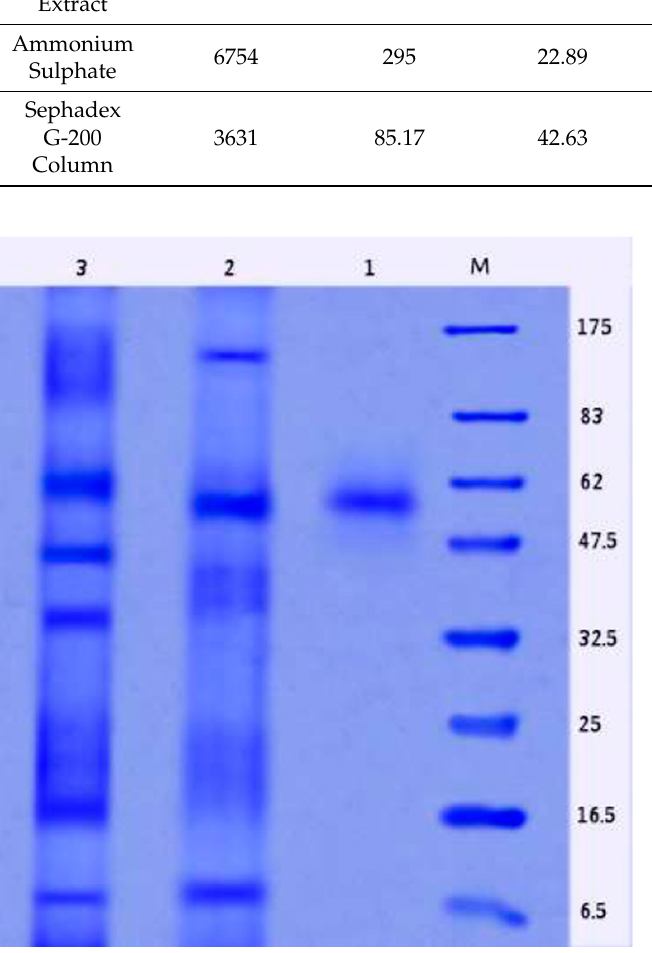
Figure 8. SDS-polyacrylamide gel electrophoresis of the purified enzyme. M: protein marker; 1: Sepharose 6B purified enzyme; 2: (NH 4 ) 2 SO 4 -precipitated enzyme; 3: cell-free crude enzyme.